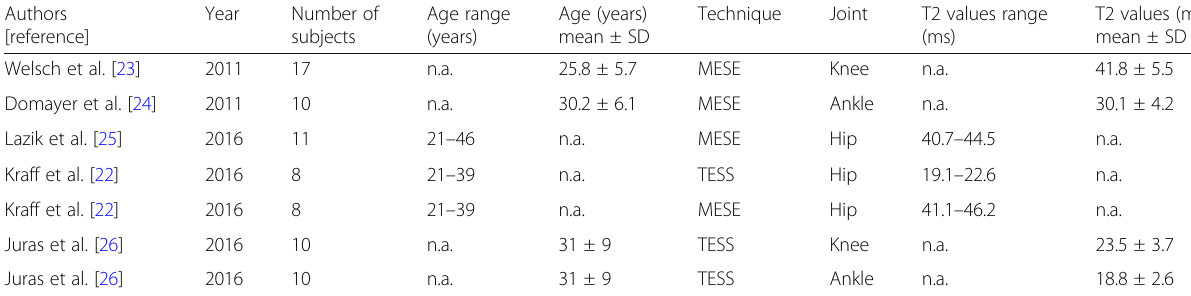
Table 2 Reference T2 values of cartilage in healthy